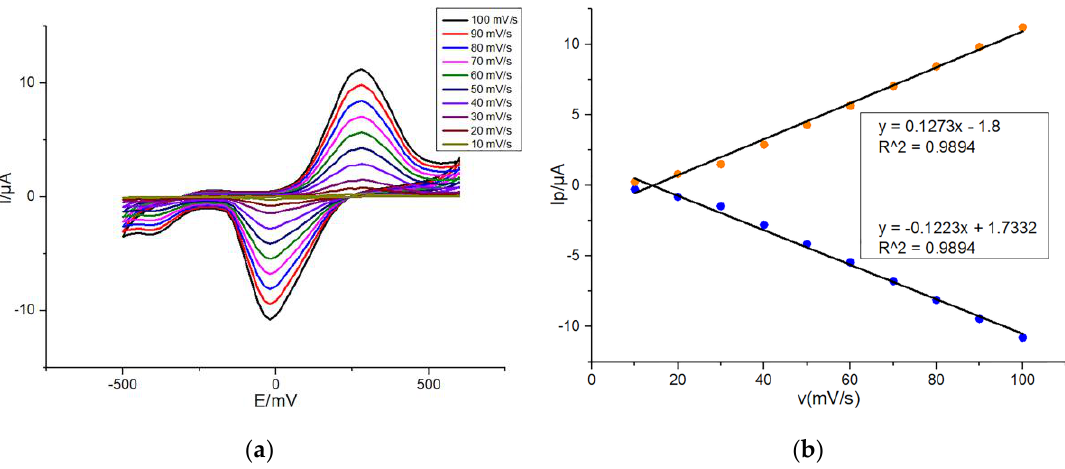
Figure 4. ( a ) CVs of 10 μM DA in 0.1-M PBS (pH: 7.4, 0.1-M KCl) at G/SPE with a scan rate from 10 to 100 mV / s in 10 mV / s steps; ( b ) Plots of peak currents of DA oxidation and reduction versus scan rates. Detection parameters: potential range from −500 to +600 mV.